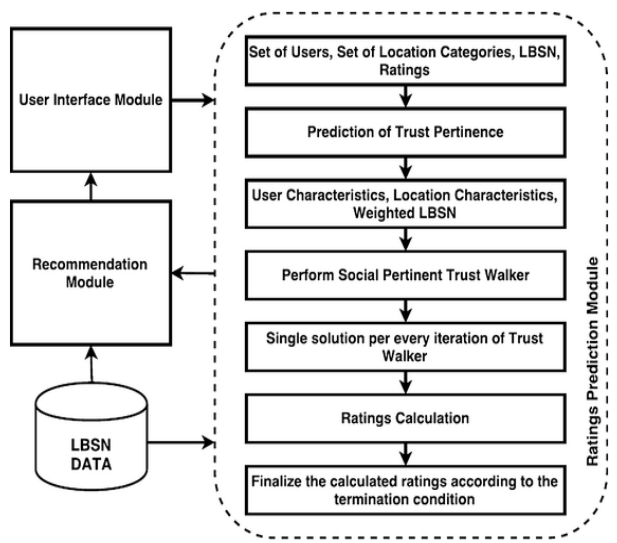
Figure 2. Proposed Tourist Analysis model using Redshit